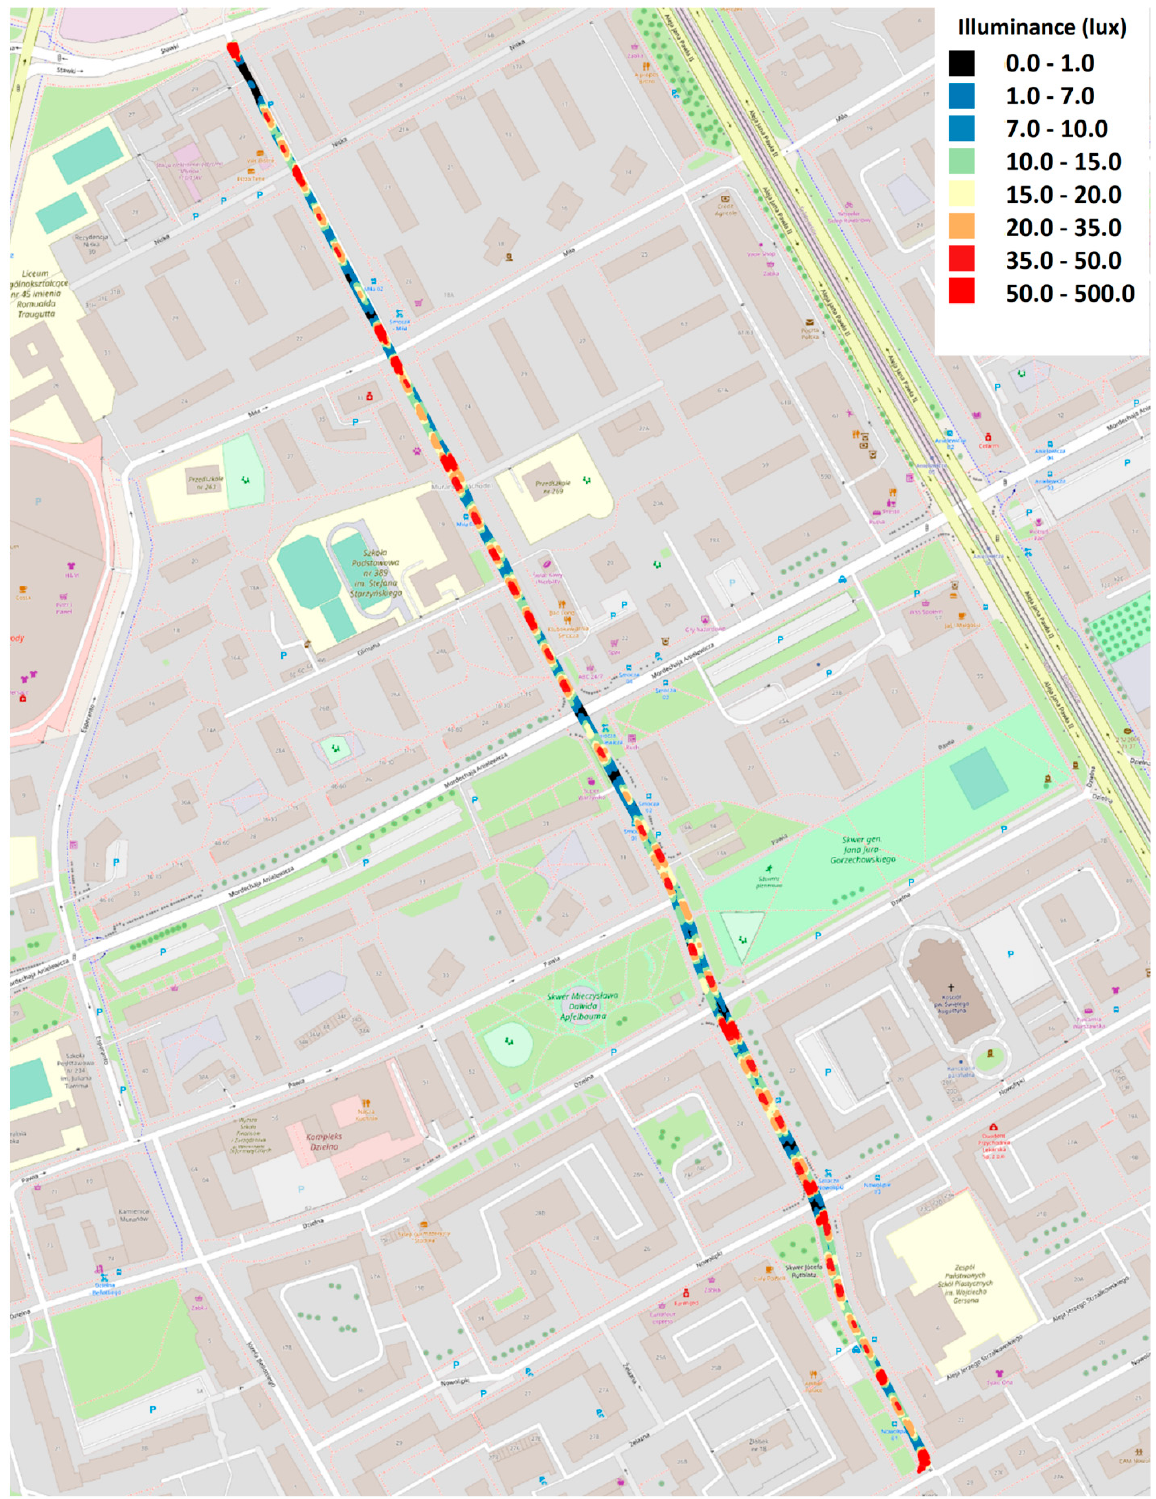
Figure 6. Map of illumination measurements in the entire section of Smocza Street.